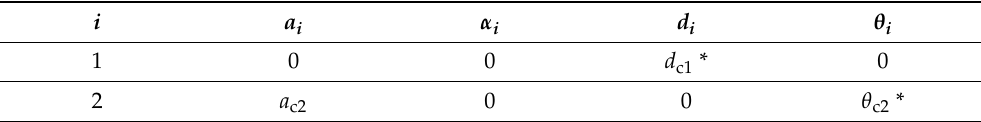
Table 1. Kinematic parameters of the 2-DoF kinematic chain representing the magnetic spring. i a i α i d i θ i d 1 * 1 0 π 2 a 2 − π 0 θ 2 * 2 The kinematic parameters for the gravity centers are presented in Table 2. Table 2. Kinematic parameters of the gravity centers of the 2-DoF kinematic chain representing the magnetic spring. i a i α i d i θ i 1 0 0 d c1 * 0 2 a c2 0 0 θ c2